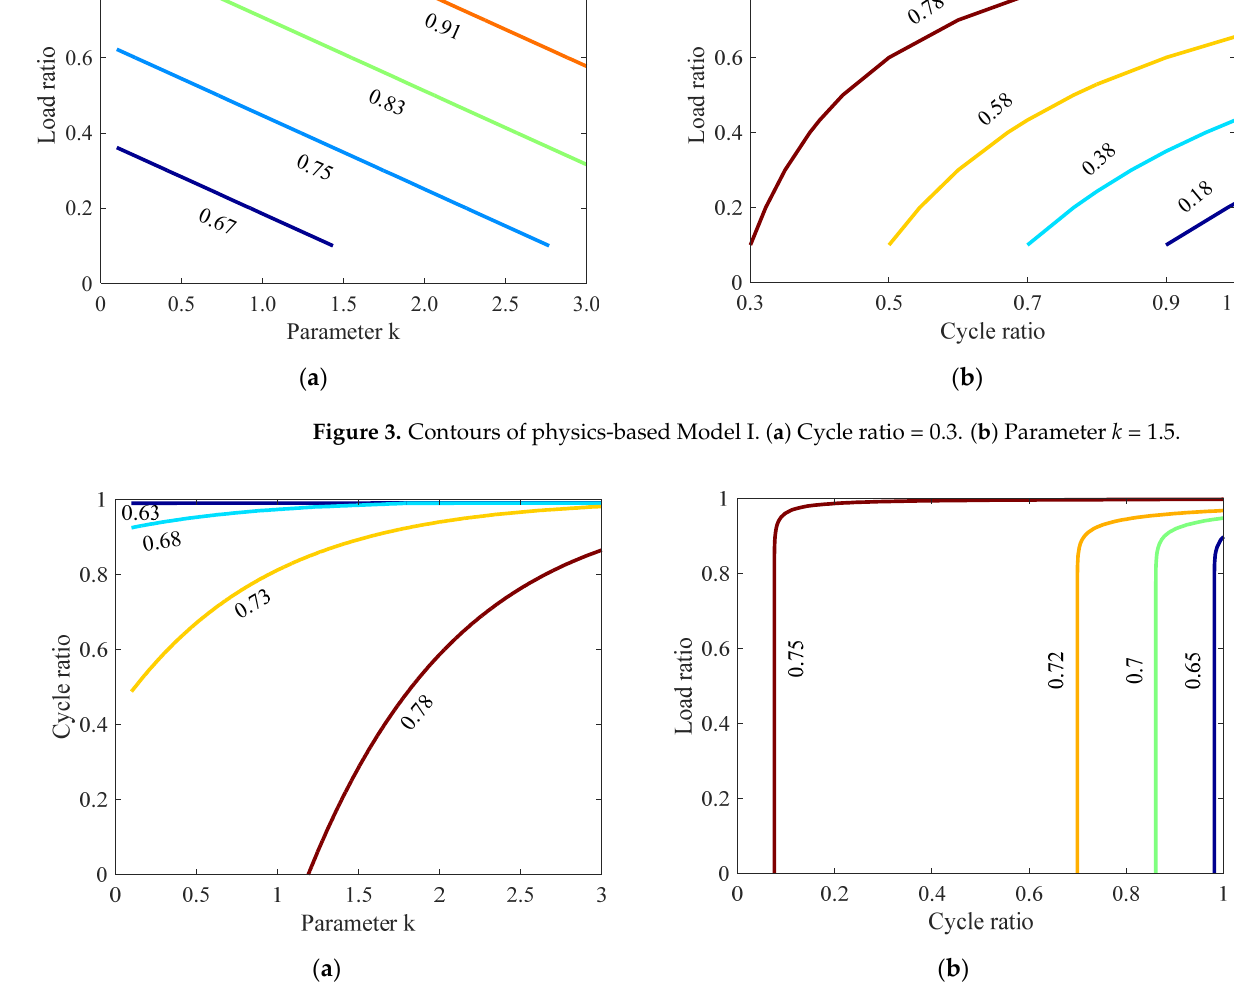
Figure 4. Contours of physics-based Model II. ( a ) Load ratio = 0.3. ( b ) Parameter k = 1.5.